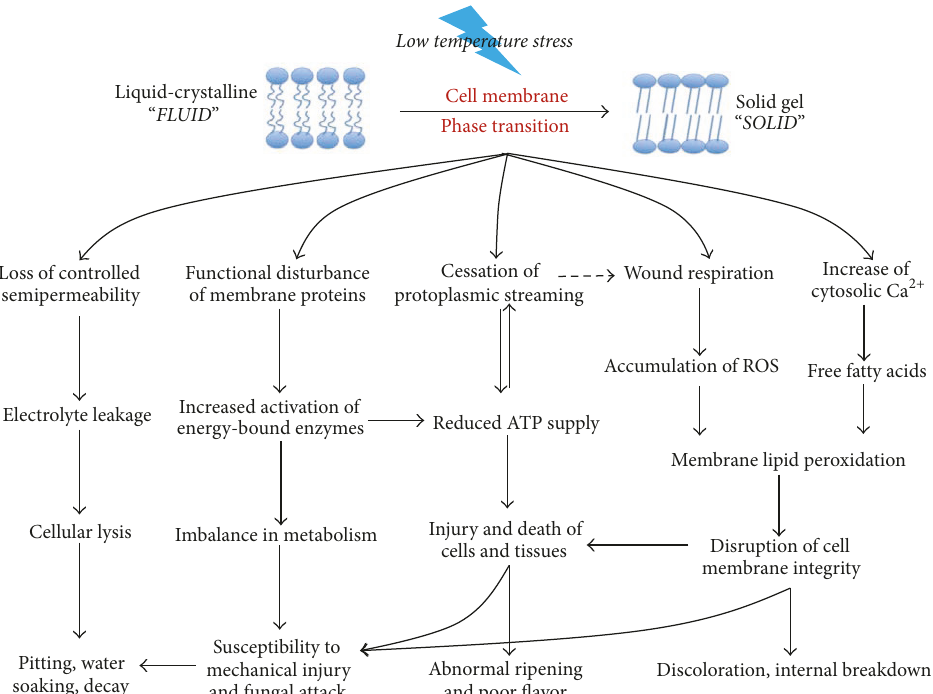
Figure 1: Possible physiological and biochemical mechanisms of chilling injury symptoms in postharvest horticultural commodities [2, 70].